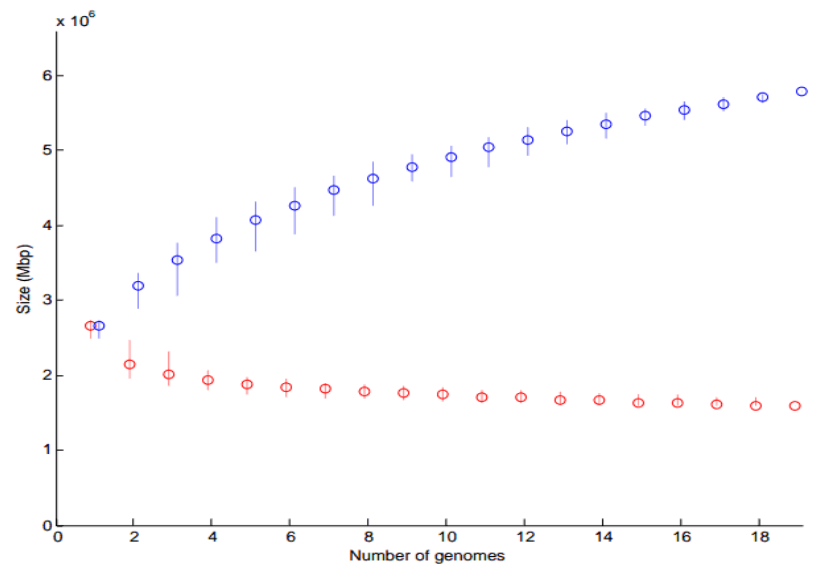
Figure 5. Core and pan-genome model of 19 A. naeslundii